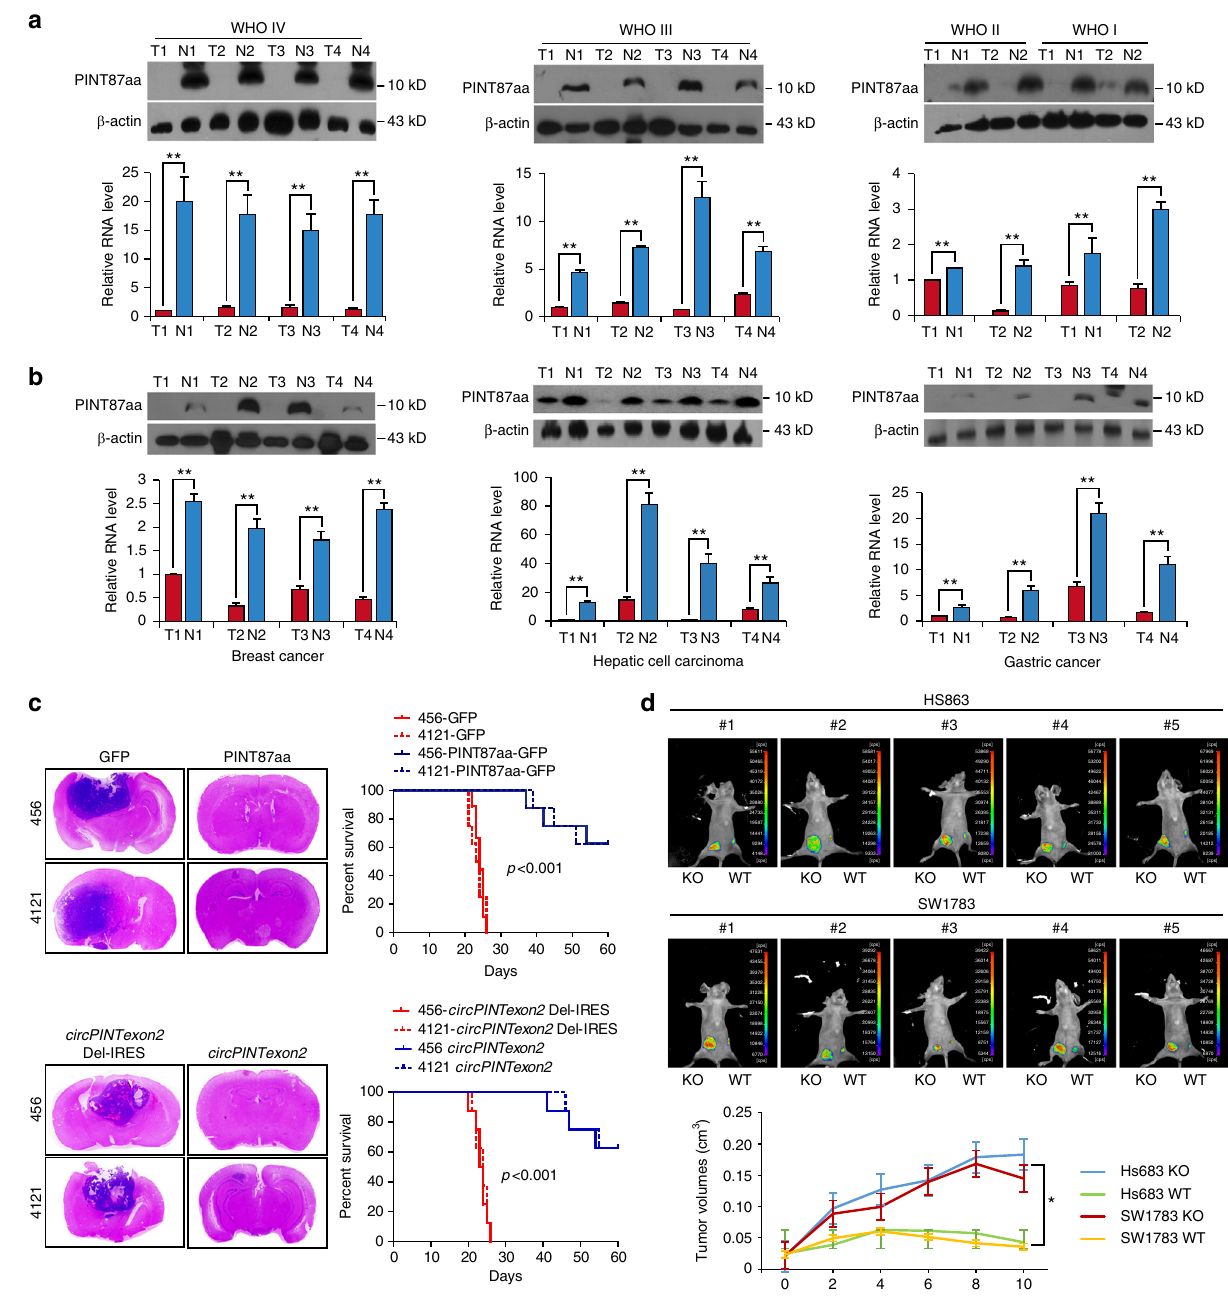
Fig. 8 Clinical implications of circPINTexon2 and PINT87aa. a Expression of circPINTexon2 and PINT87aa in human glioma samples with different WHO grades and matched adjacent normal tissues. b Expression of circPINTexon2 and PINT87aa in breast cancer, hepatic cellular carcinoma, gastric cancer, and adjacent normal tissues. c Anti-cancer effects of PINT87aa in vivo; left, mice with brain xenograft tumors were sacri fi ced 60 days after implantation; right, Kaplan – Meier survival curves of mice implanted with 456 and 4121 cells stably overexpressing PINT87aa and their respective parental cells ( N = 8 mice/ treatment group, P < 0.001, two-tailed log-rank test). d Nude mice were subcutaneously injected with 5 × 10 6 Hs683 and SW1783 PINT87aa K.O. cells and their parental cells using Matrigel and were then monitored daily. Day 0 indicates the fi rst day of injection. Tumor progression was monitored using a small animal imaging system or through caliper measurements. Error bars indicate standard error ( N = 5 mice/treatment group, P < 0.01, two-tailed log-rank